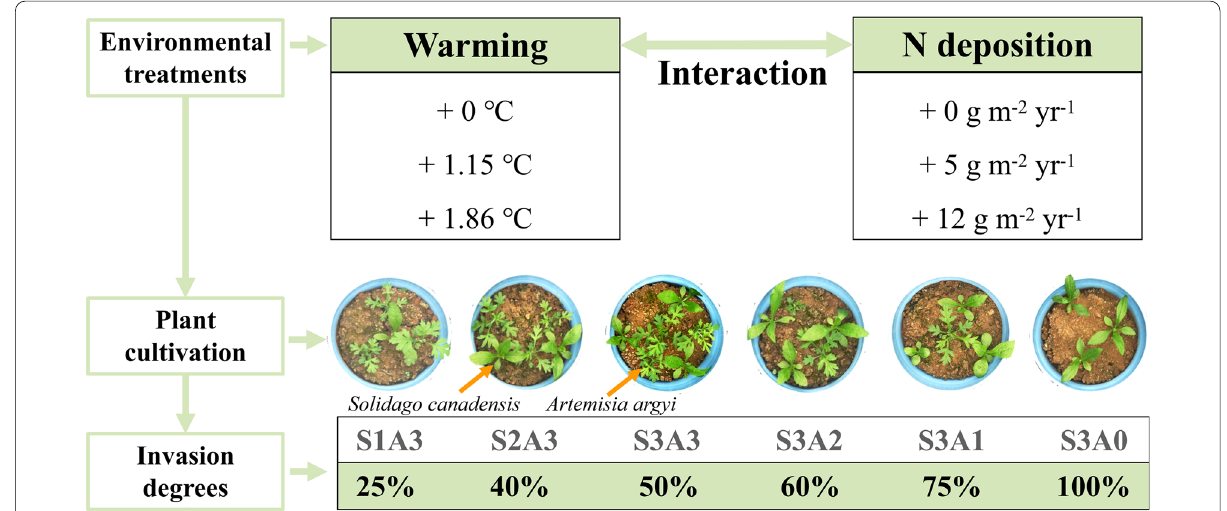
Fig. 1 Experimental design showing: warming and elevated nitrogen deposition effect on the invasion process of Solidago canadensis